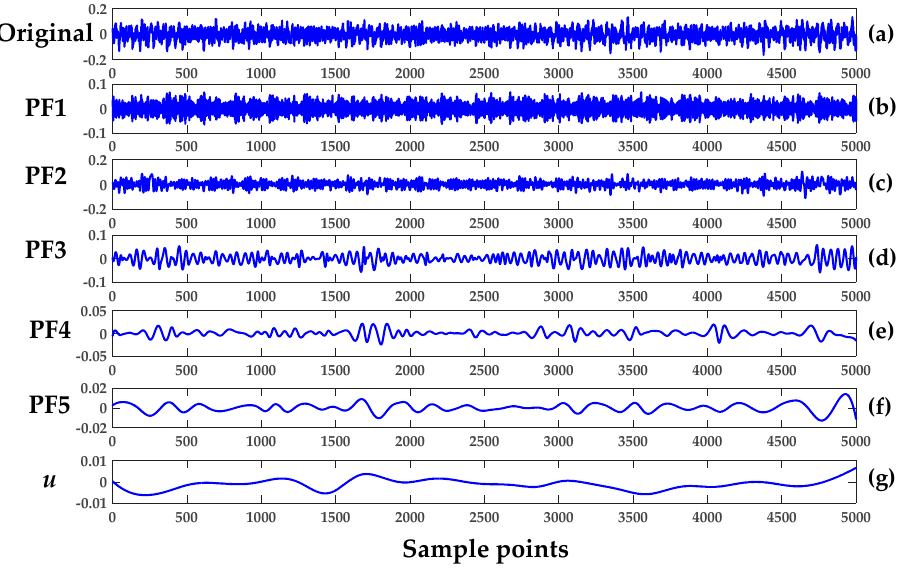
Figure 4. LMD of normal healthy Case 1: ( a ) original H1; ( b ) PF1; ( c ) PF2; ( d ) PF3; ( e ) PF4; ( f ) PF5; and ( g ) u is the residual signal.